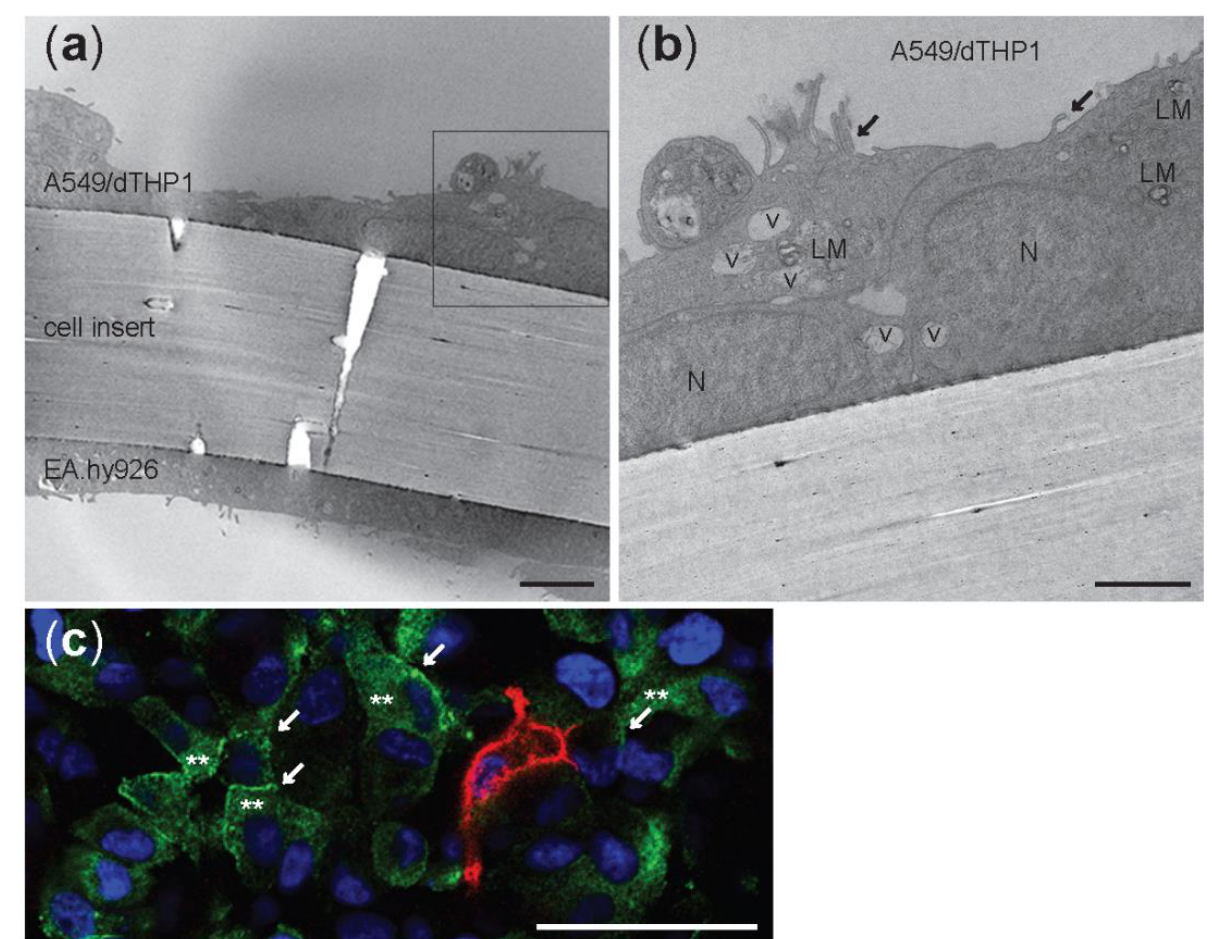
Figure 3. Transmission electron microscopy micrographs ( a , b ) and confocal picture © of unexposed triculture with A549 and dTHP-1 cells at the apical side and EA.hy926 cells at the basolateral side of a cell insert with 1 µ m pore size membrane. LM: lamellar bodies; v: vesicles; N: nuclei; black arrows: microvilli. ( a ) Scale bar: 5 µ m. ( b ) Scale bar: 1 µ m. ( c ) Confocal image of the apical side. A549 were stained with ZO-1 antibody (green) and differentiated THP-1 with CD11b (red). White arrows: tight junctions. **: cytoplasmic ZO-1. Nuclei are stained in blue (DAPI). Scale bar: 50 µ m; Magnification: 40 ×.